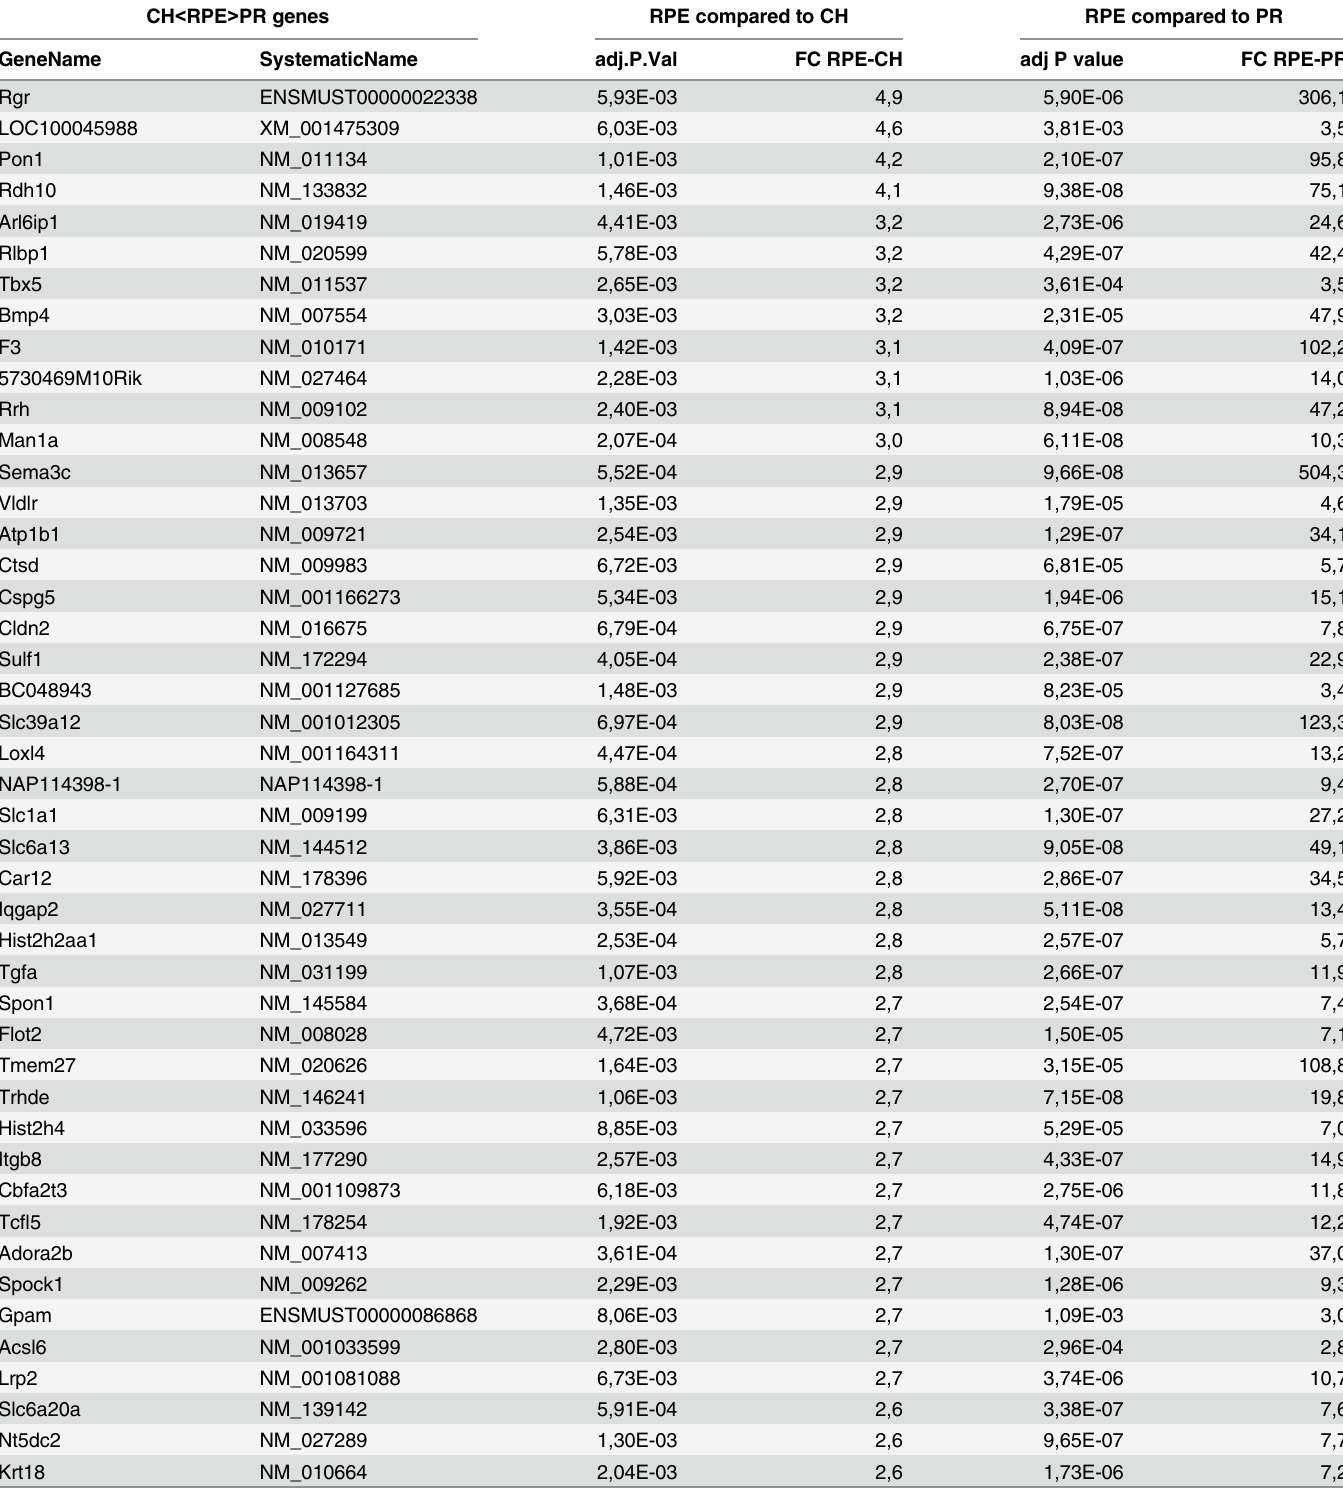
Table 1. Our “ Mouse RPE signature genes ” dataset: 64 mouse RPE genes with an average expression of at least 2.5 fold higher in the mouse RPE than in both the PR and the CH with an adjusted p-value smaller than